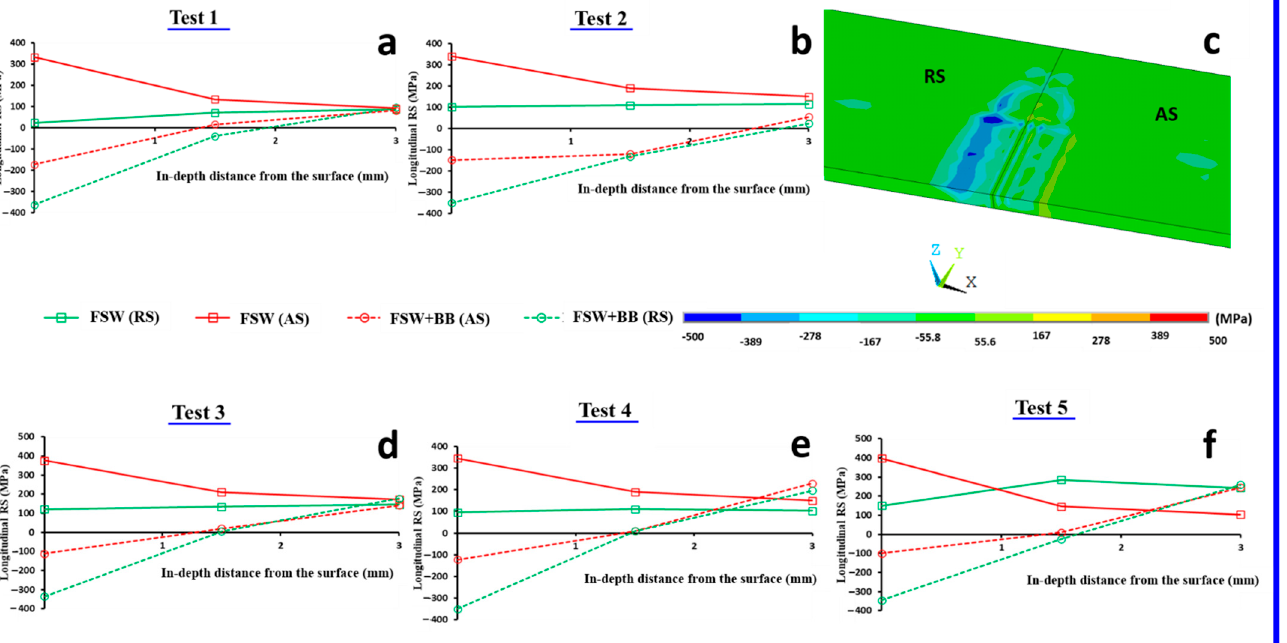
Figure 20. ( a , b , d – f ) Comparison in-depth residual stress distribution after FSW and BB ( c ) LRS contour for test two after FSW + BB.